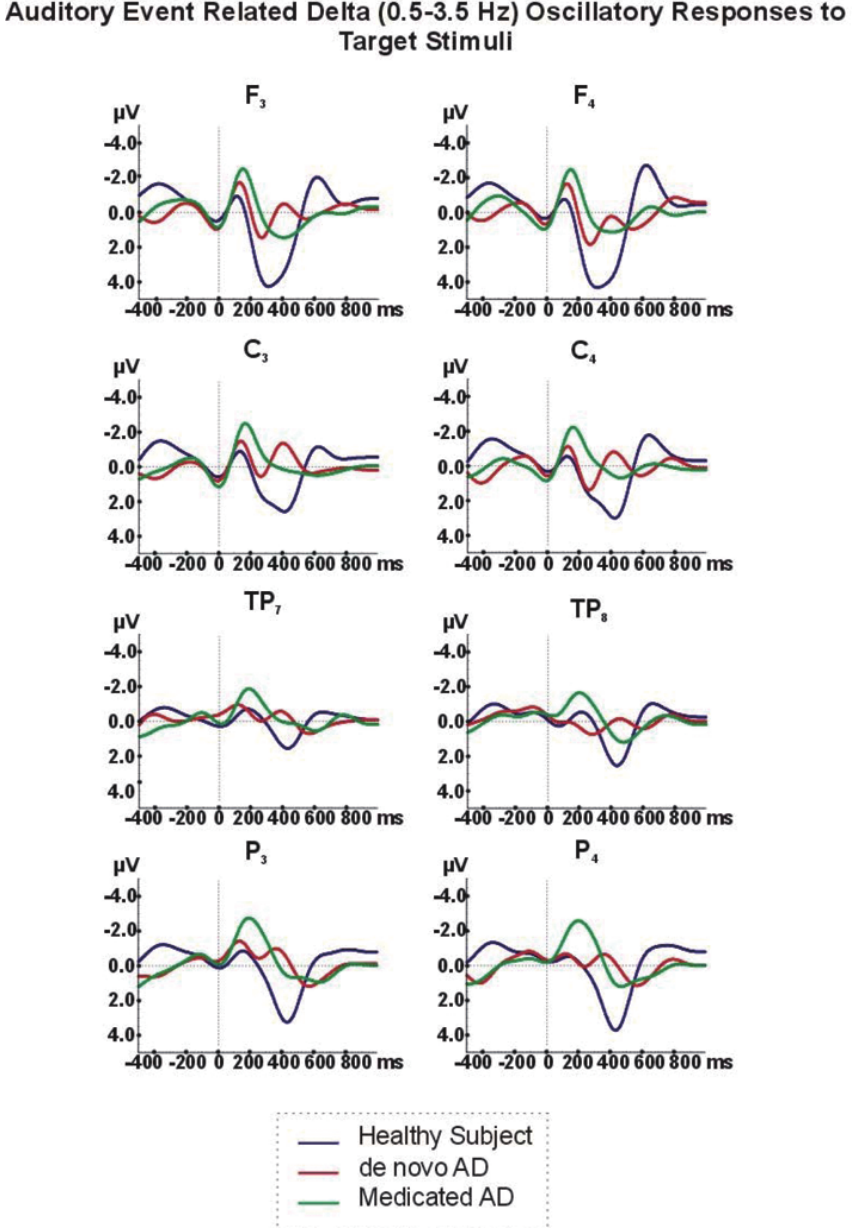
Fig. 1. Auditory event-related oscillations (ERO) delta (0.5-3.5 Hz) Responses to target stimuli in Alzheimer’s disease (AD) groups and healthy elderly controls. The fronto-centralareas showed nearly 75 percent larg- er values than temporal regions. In frontal or central locations, delta response peak to peak amplitudes of the healthy controls may reach to 7–9 microvolts whereas they are reduced by approximately 30 percent in both groups of